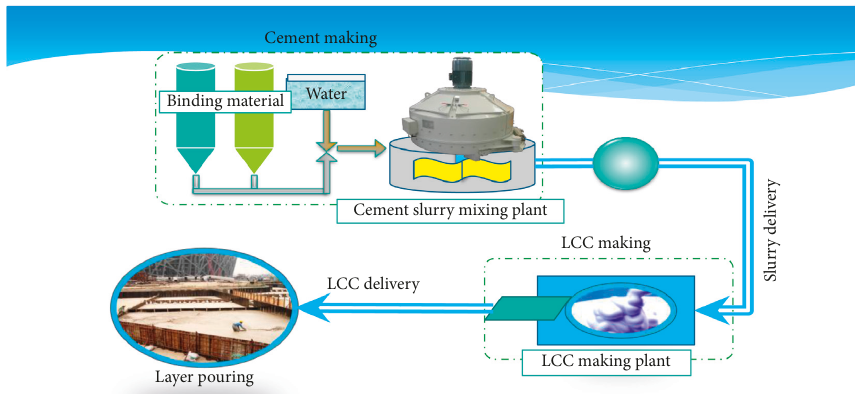
Figure 5: Process flowchart of preparation of lightweight concrete.